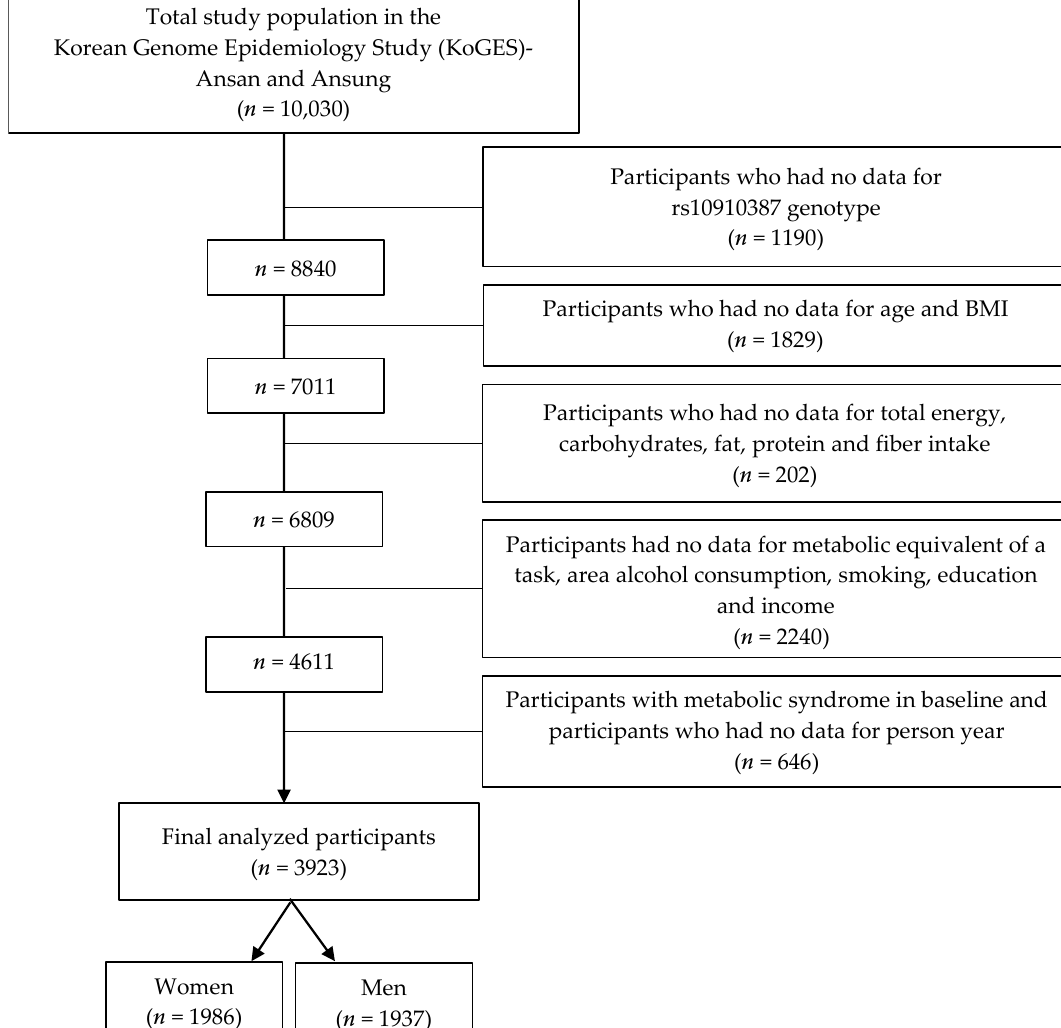
Figure 1. Flow chart for the study design: participants and exclusion criteria.